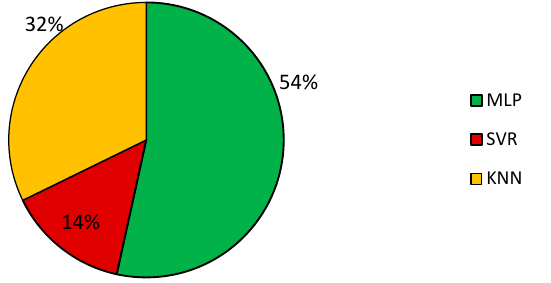
Figure 5. Weights of sub-models in stacking algorithm.